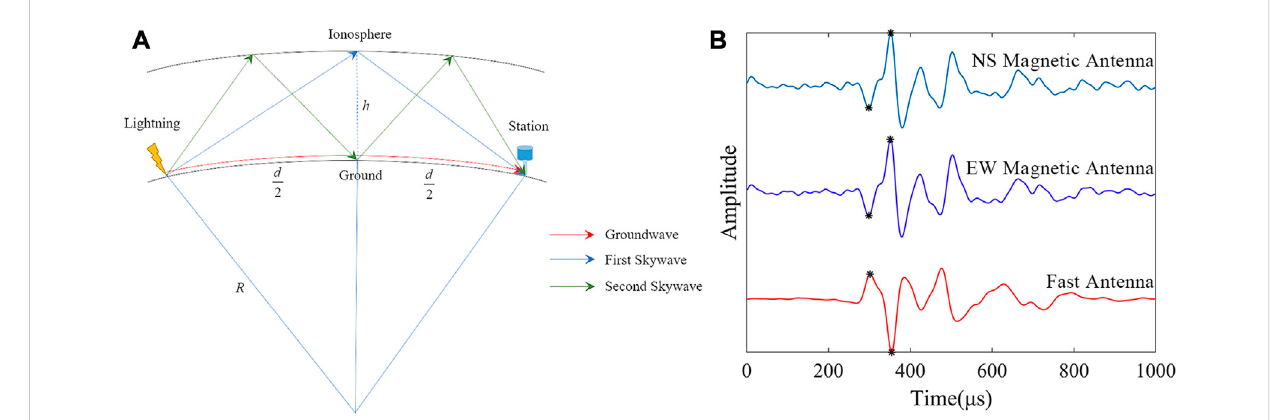
FIGURE 4 Lightning signal propagation in EIWG. (A) Schematic diagram of the fi rst and second skywave re fl ections in EIWG; (B) Lightning waveform.